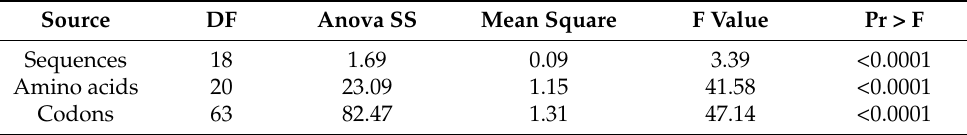
Table 2. The ANOVA for MRCBS, amino acids and codons for the Solanum lycopersicum cultivar Heinz